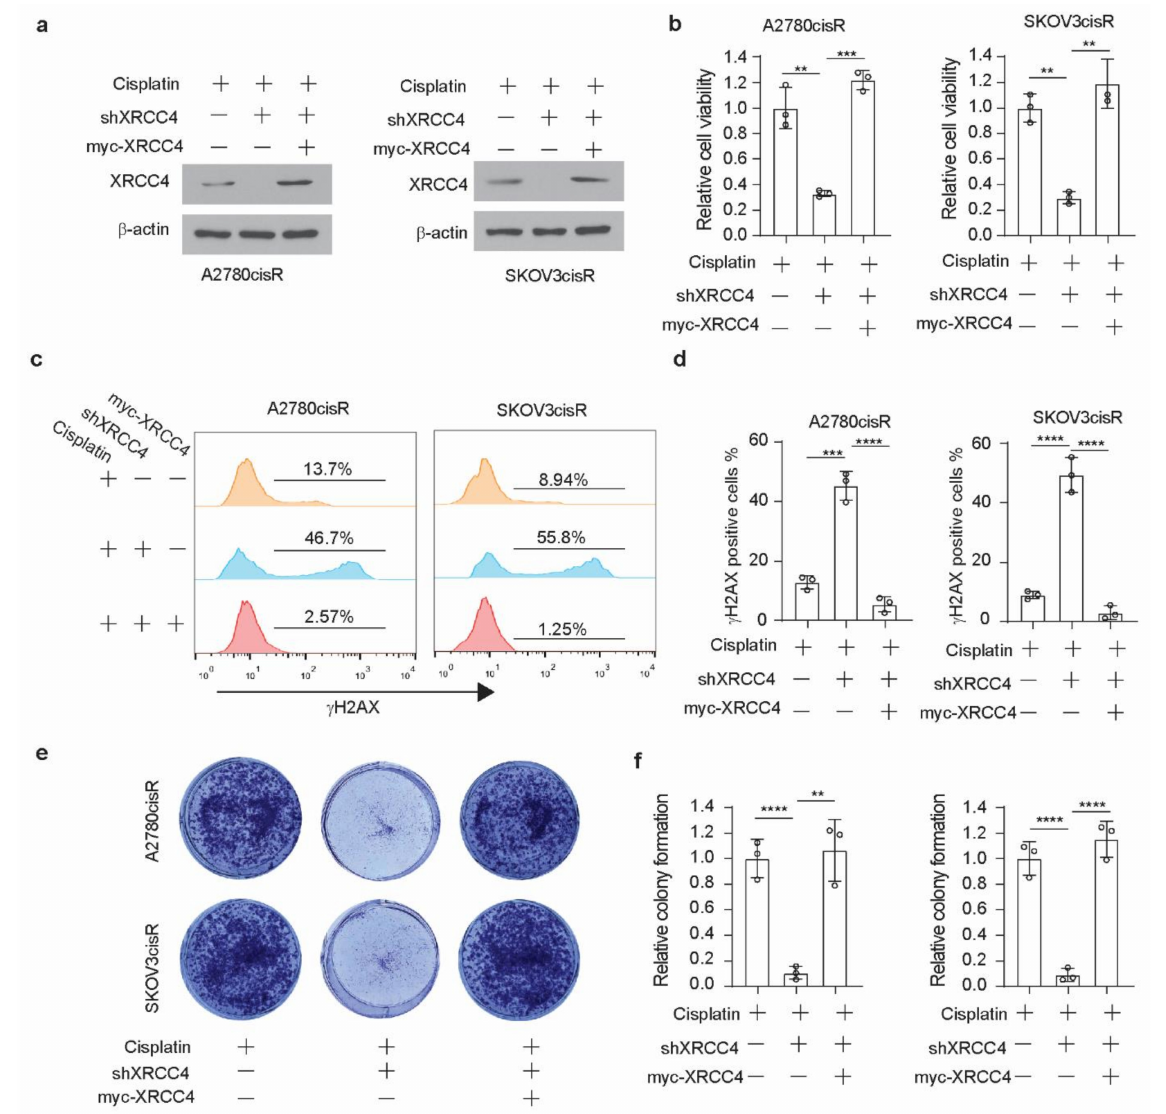
Figure 4. Rescued expression of XRCC4 reduced DNA damage in cisplatin-resistant ovarian cells upon cisplatin treatment. ( a ) Confirmation of the rescued expression of XRCC4 in the XRCC4 knock- down A2780cisR and SKOV3cisR by Western blot. ( b ) Cell viability of control, XRCC4 knockdown, and XRCC4 rescued A2780cisR and SKOV3cisR cells treated with the sublethal doses of cisplatin (5 µ g/mL A2780cisR and 2 µ g/mL SKOV3cisR) for 48 h. Cell viability was determined by CellTiter- Glo luminescent cell viability assay. ( c , d ) FACS analysis ( c ) and quantification ( d ) of γ H2AX level in the indicated cells (treatment: cisplatin, 5 µ g/mL A2780cisR, and 2 µ g/mL SKOV3cisR for 48 h). ( e , f ) Colony formation potential ( e ) and quantification ( f ) of the indicated A2780cisR and SKOV3cisR. Cells were treated with the sublethal doses of cisplatin (5 µ g/mL A2780cisR and 2 µ g/mL SKOV3cisR) for 48 h. Data are mean ± SD from 3 technical replicates of each sample and are representative of 2 ( a ), 2 ( b ), and 3 ( c – e ) independent biological experiments. Statistical analysis was performed by 1-way ANOVA for all data; ** p < 0.01; *** p < 0.001; **** p <